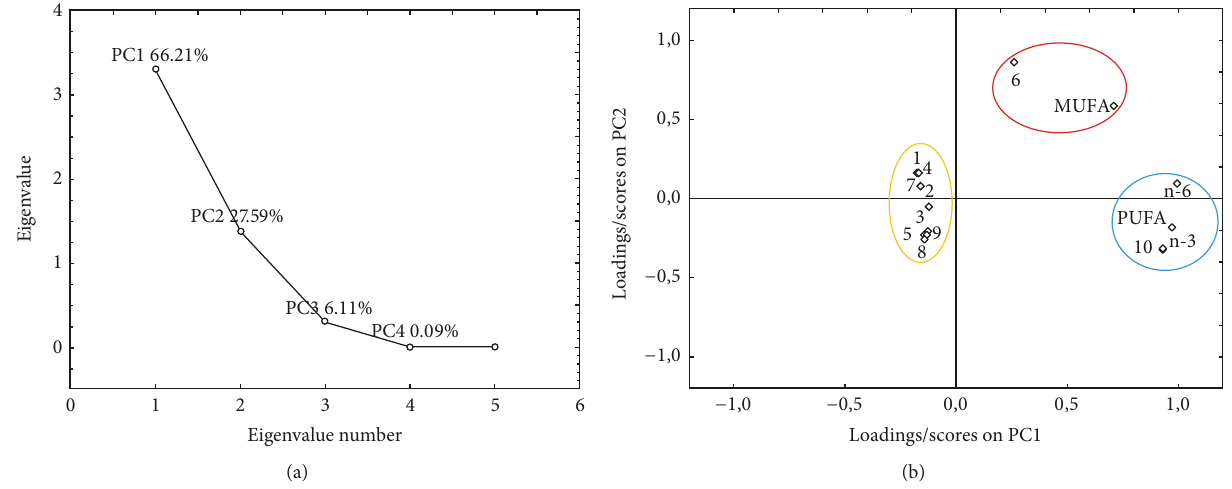
Figure 2: PC: principal component; (a) eigenvalue number; (b) loadings (variables)/scores (samples) biplot of fatty acids for the first and second PC of different parts of fruits: 1: S. cumini pulp; 2: S. cumini peel; 3: S. cumini seed; 4: S. nigrum pulp; 5: S. nigrum peel; 6: S. nigrum seed; 7: I. edulis pulp; 8: I. edulis seed; 9: H. dulcis pulp and peel; 10: H. dulcis